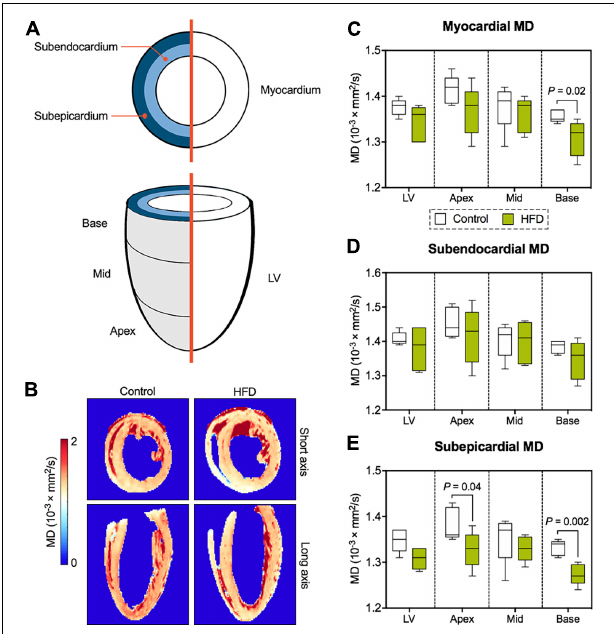
FIGURE 4 | Analysis of myocardial diffusion metrics. (A) Illustration of DT-MRI segmentation. All DT-MRI parameters were assessed for both the global myocardium or separately for the subendocardial and subepicardial layer as well for the entire LV and its different segments (base/mid-cavity/apex). (B) Representative MD maps. Analysis of MD in the global myocardium (C) , the subendocardium (D) , and subepicardium (E) of the LV. Median and quartiles with 95% confidence interval; unpaired Student’s t -test; n = 5 per